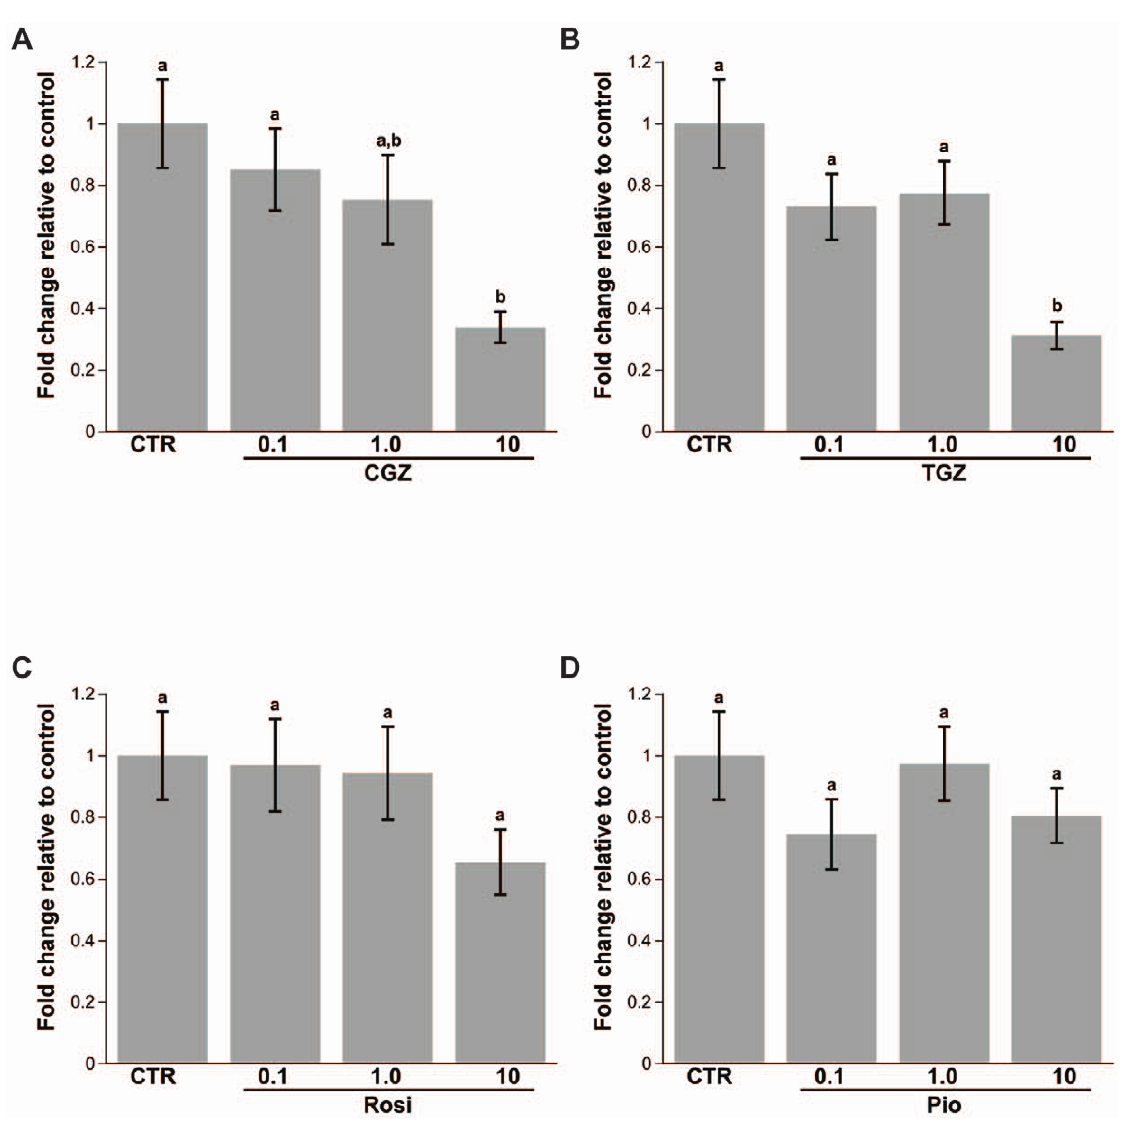
Figure 4. Effect of TZD treatment on Ovcar3 cell proliferation. Ovcar3 cells were serum starved for 24 hours and treated for an additional 24 hours with vehicle control (DMSO) or 0.1, 1.0 or 10 m M of CGZ ( A ), TGZ ( B ), Rosi ( C ), Pio ( D ). Cell proliferation was assessed with the BrdU assay. Results are the means 6 SEM for at least 3 measurements from three individual experiments. Bars that do not share a letter designation are significantly different within a treatment group ( p ,